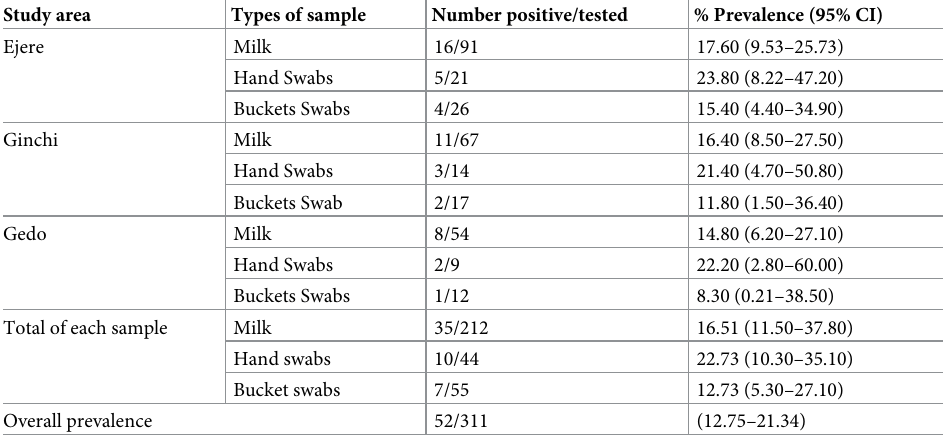
Table 2. Percentage of S . aureus isolated from raw milk, hand, and milking buckets swab samples in the study